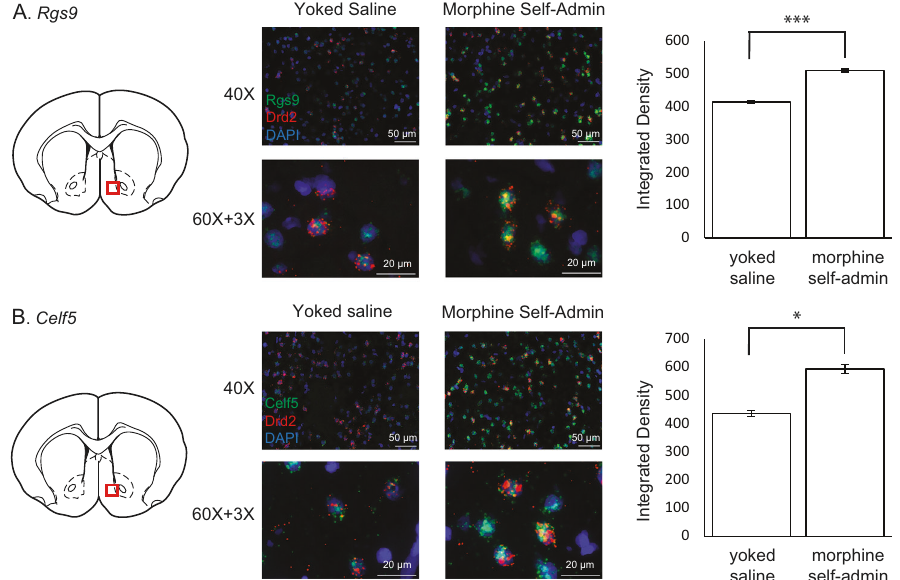
Fig. 5 Fluorescence in situ hybridization. RNAscope was used to validate the differential expression of Rgs9 ( A ) and Celf5 ( B ) in Drd2 expressing medium spiny neurons in rats self-administering morphine or their saline yoked controls. Each gene was assessed in four animals ( n = 4 slices each), and example images for the yoked saline or morphine self-administration are presented. Quanti fi cation of integrated fl orescence density (see Methods) con fi rmed the increased expression of both genes in Drd2 expressing neurons of animals that self- administered morphine. * p < 0.05. *** p <